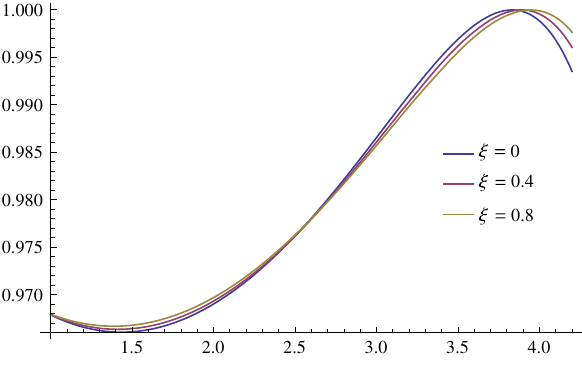
Fig. 5 Greybody factor as a function of ω r h for different values of ξ , when (cid:5) = 0 . 01, q = 3 . 5 and l =